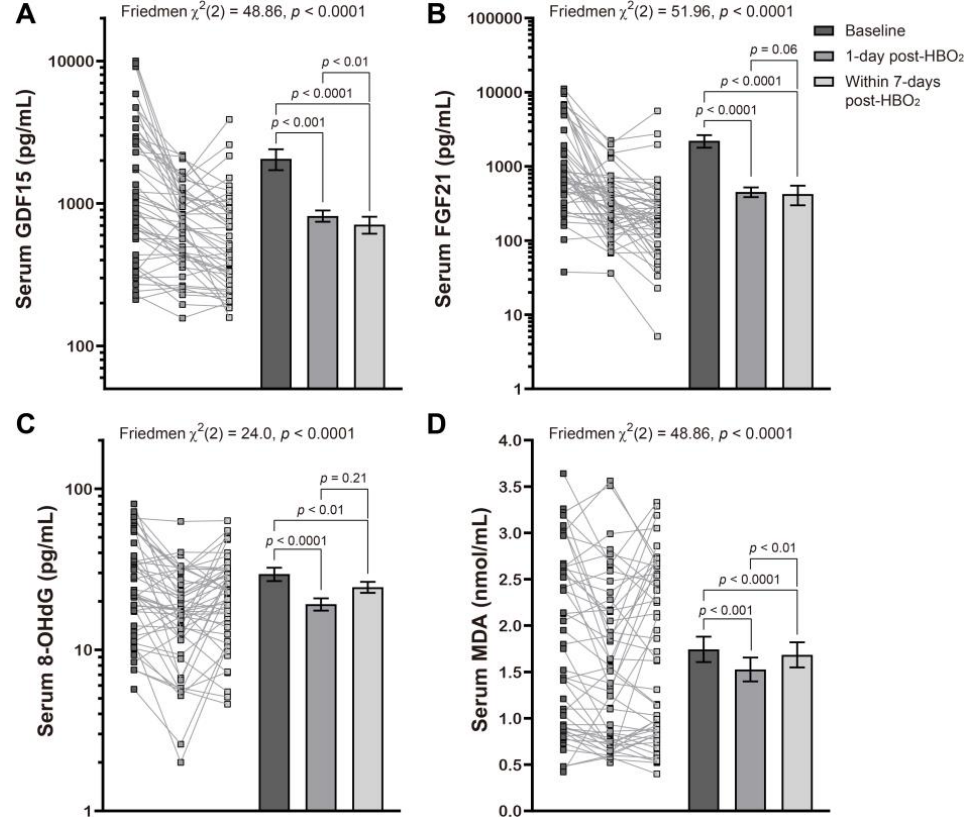
Figure 1. Effects of hyperbaric oxygen treatment on the serum levels of several mitochondrial and oxidative stress biomarkers. Changes in serum levels of GDF15 ( A ), FGF21 ( B ), 8-OHdG ( C ), and MDA ( D ) at baseline, l day post and within 7 days of HBO 2 therapy, in patients with CO poisoning were evaluated using a Friedman test followed by a Dunn’s multiple comparison correction. Symbols represent the individual values from the patient cohort while the bars represent the mean ± standard error of the mean for each group. Note that the y axis is described using the log scale in panels ( A – C ). Table 2. Summary of the biomarkers values from the patient cohort. Table 2 and Figure 2 present the correlation between neurocognitive sequelae and Total Favorable Outcome Poor Outcome serum GDF15, FGF21, 8-OHdG, and MDA levels. Baseline GDF15 ( p < 0.001) and 8-OHdG ( p = 0.026) were significantly higher in the poor outcome group than in the favorable out- come group. HBO 2 therapy induced significantly increased Δ% GDF15 ( p = 0.005), FGF21 ( p = 0.061), 8-OHdG ( p < 0.001), and MDA ( p < 0.001) in the poor outcome group.